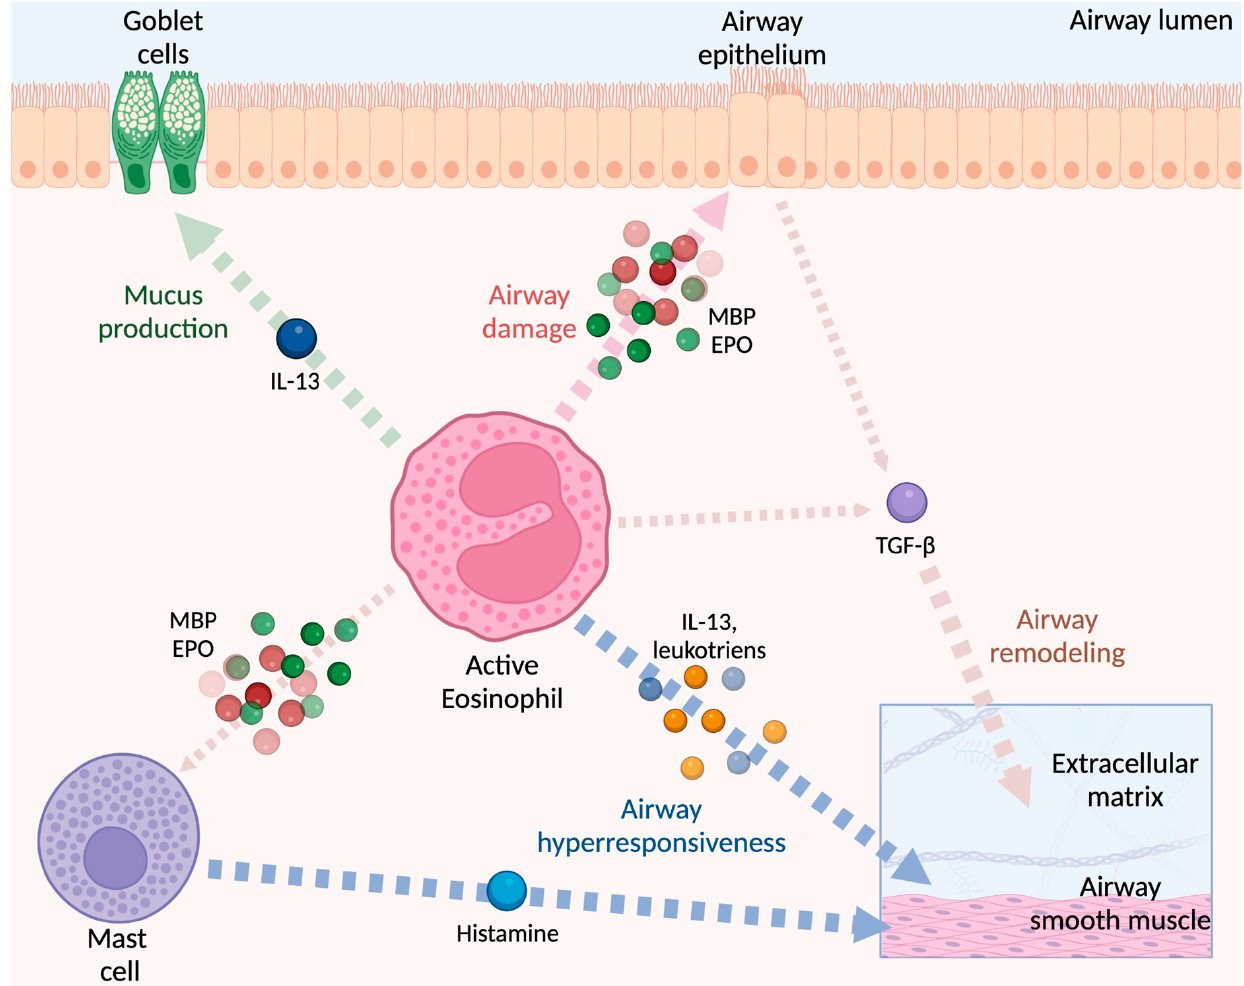
Figure 3. The centrality of the eosinophil in the pathophysiology of T2 asthma. The main effect can be summarized in four peculiar activities: airway damage, airway remodeling, airway